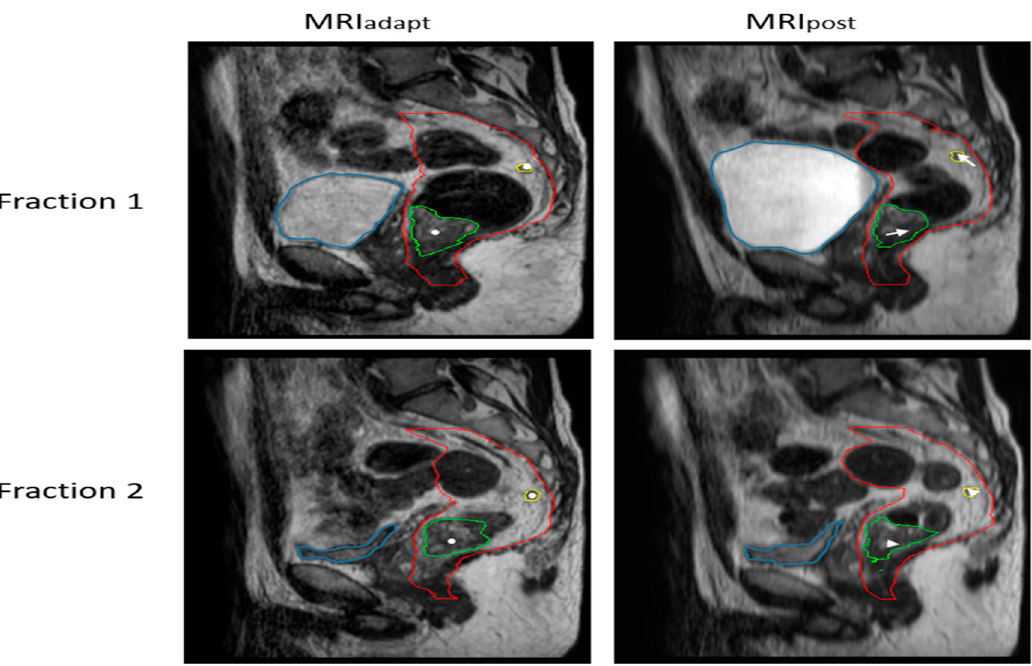
Figure 1. Magnitude of the intrafraction shift of GTV prim (green contour) and GTV ln (yellow contour) during two fractions as a result of bladder filling (blue contour) and consequent mesorectal shape variation (red contour). The white dots denote the COG of the structures on MRI adapt , and the arrows on MRI post show the magnitude of the intrafraction shift. In fraction 1, as a result of increasing bladder filling, relatively large intrafraction motion is seen. In fraction 2, the bladder remains stable during treatment.